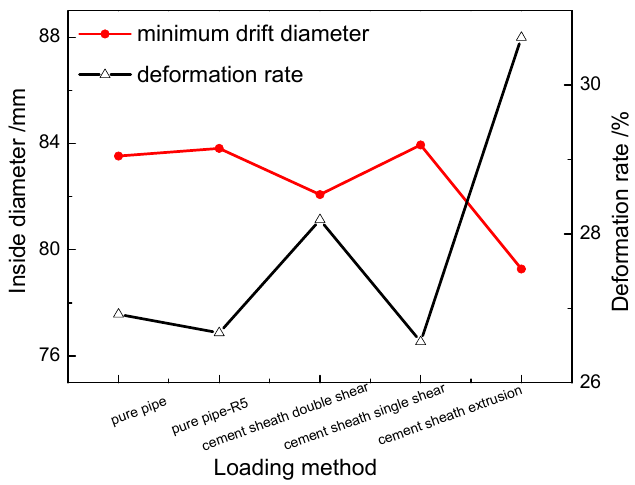
Figure 15. Influence law of different loading methods on casing inner diameter.